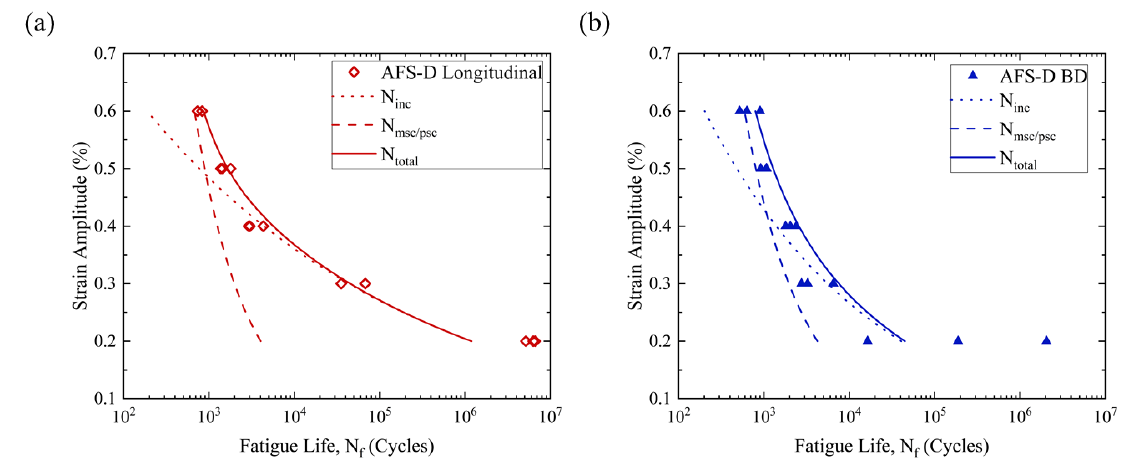
Figure 9. MSF model plots of the incubation and small crack growth contributions to the total fatigue life prediction for ( a ) AFS-D AA6061 in the longitudinal direction and ( b ) AFS-D AA6061 in the build direction.